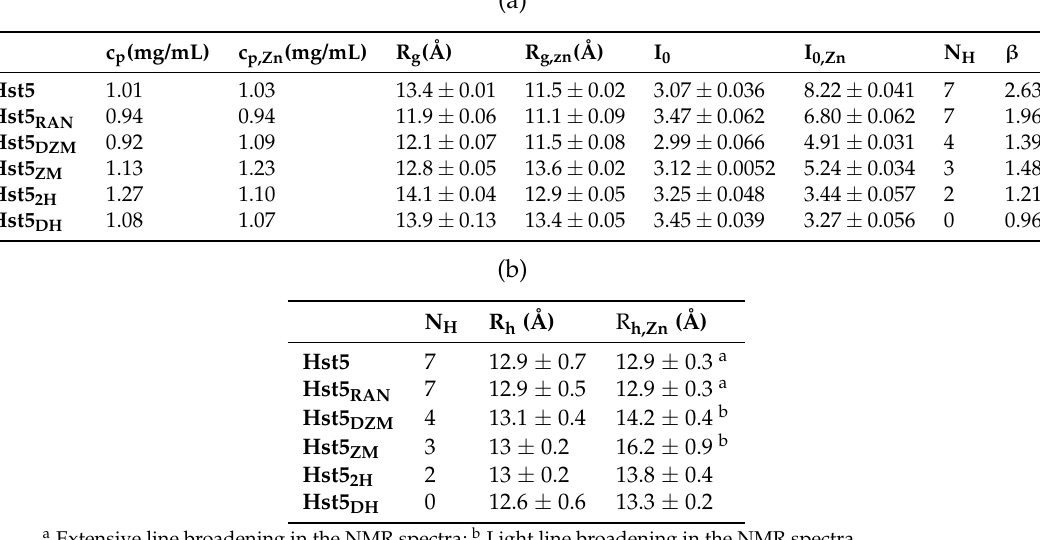
Table 2. Conformational properties from SAXS and NMR of Hst5 and variants. Experiments were performed as described in the methods section. All results are given in the absence and in the presence Zn 2+ , where Zn is added in the subscript to denote the latter.